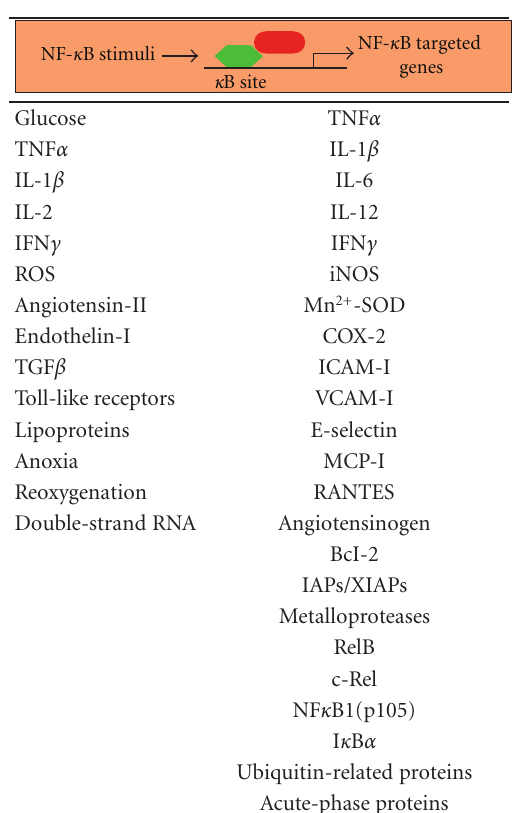
Table 1: Potential main stimuli and NF- κ B-related genes involved in DC. Di ff erent stimuli can activate NF- κ B signalling (left) and several targeted genes (right) may be controlled by NF- κ B in the diabetic heart. COX2: cyclooxygenase-2; Mn 2+ -SOD: manganese- superoxide dismutase; IFN γ : interferon- γ ; RANTES: regulated upon activation normal T cell expressed and secreted. The rest of abbreviations are described along the